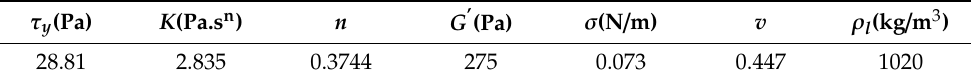
Table 1. Properties of 3% Laponite RD